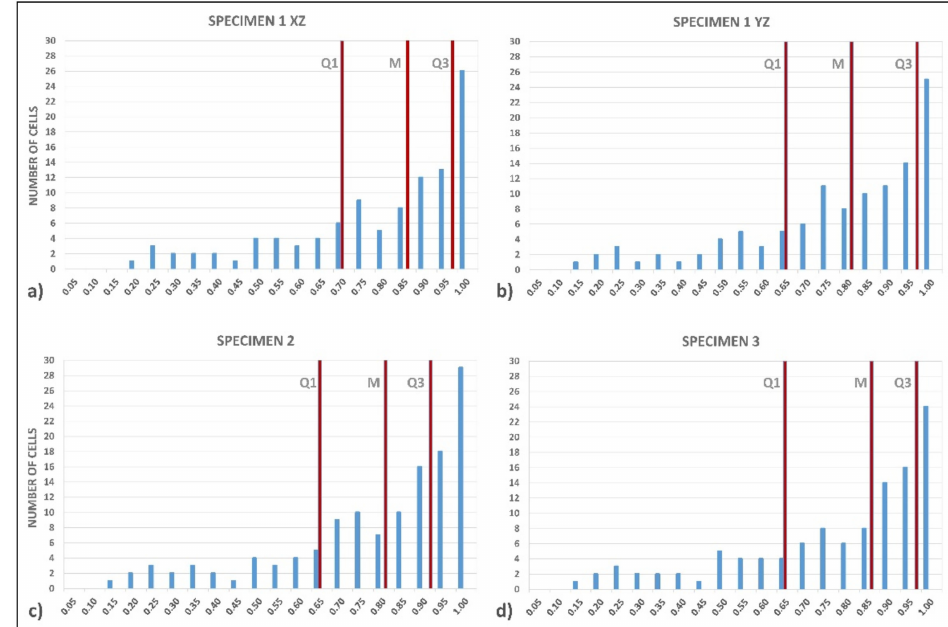
Figure 14. Analysis and comparison of the distributions of the circularity C: ( a , b ) Longitudinal sections XZ and YZ of reference Specimen 1, as defined in Figure 2; ( c , d ) Longitudinal sections (randomly chosen) of Specimens 2 and